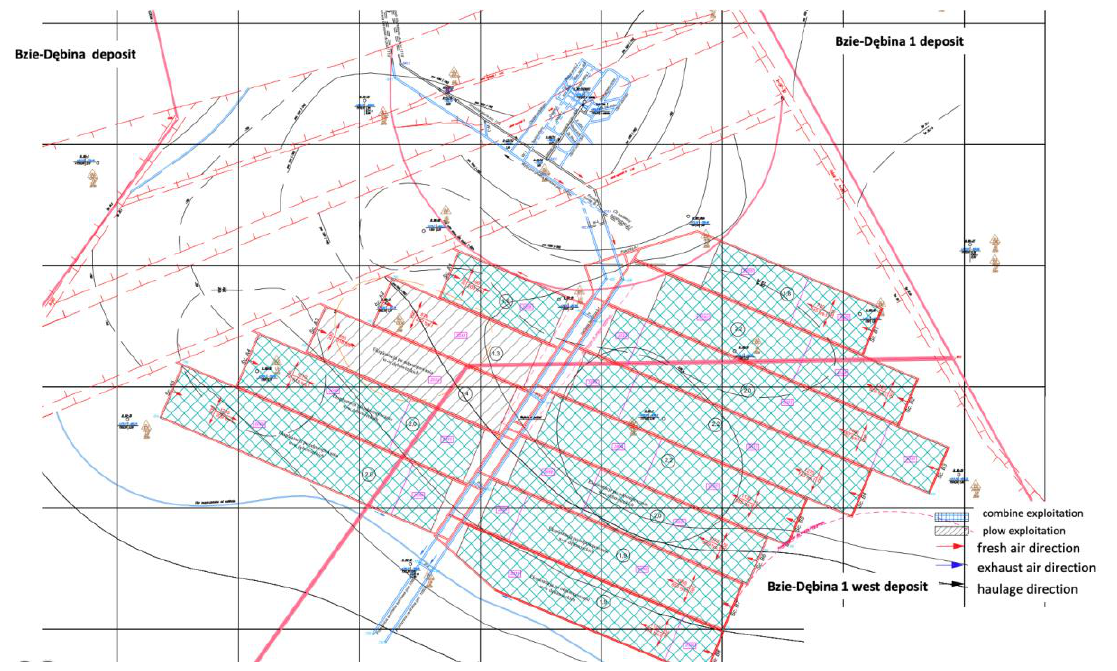
Figure 6. Map of the designed mining operations in the coal seam 403/1.